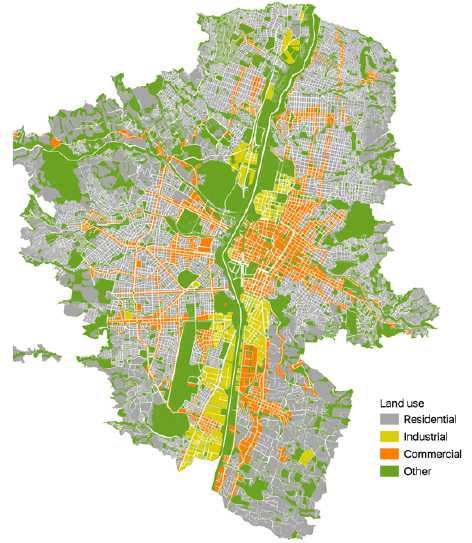
Figure 3. Medellin land use map.